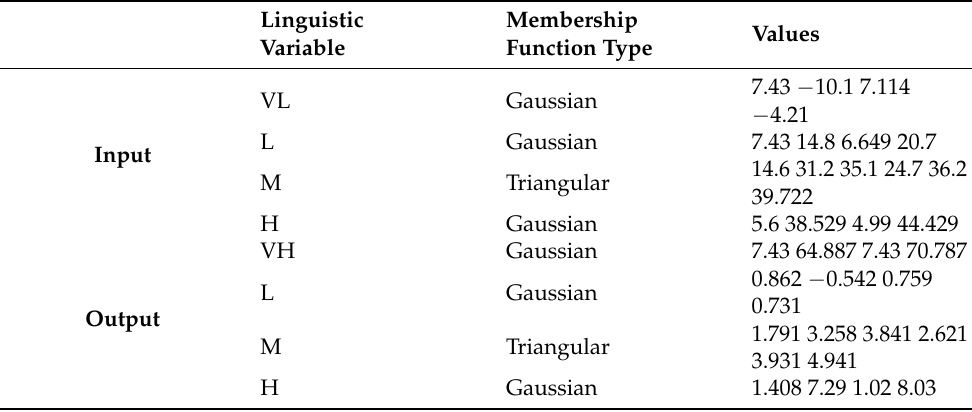
Figure 5. Best type-2 fuzzy system to control the insulin pump injection. Table 4. Results for the type-2 fuzzy control for optimal supply of insulin. Table 5. Parameters of the type-2 membership